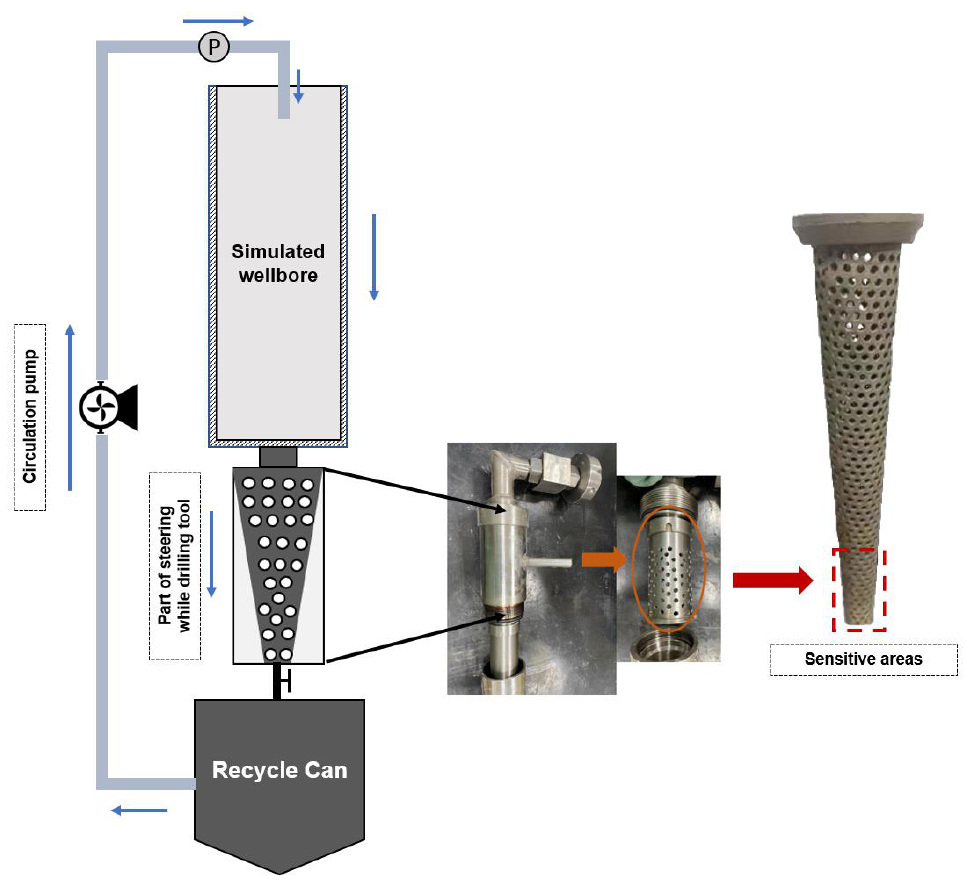
Figure 5. The experimental device for the blocked safety test of the mud screen tool.